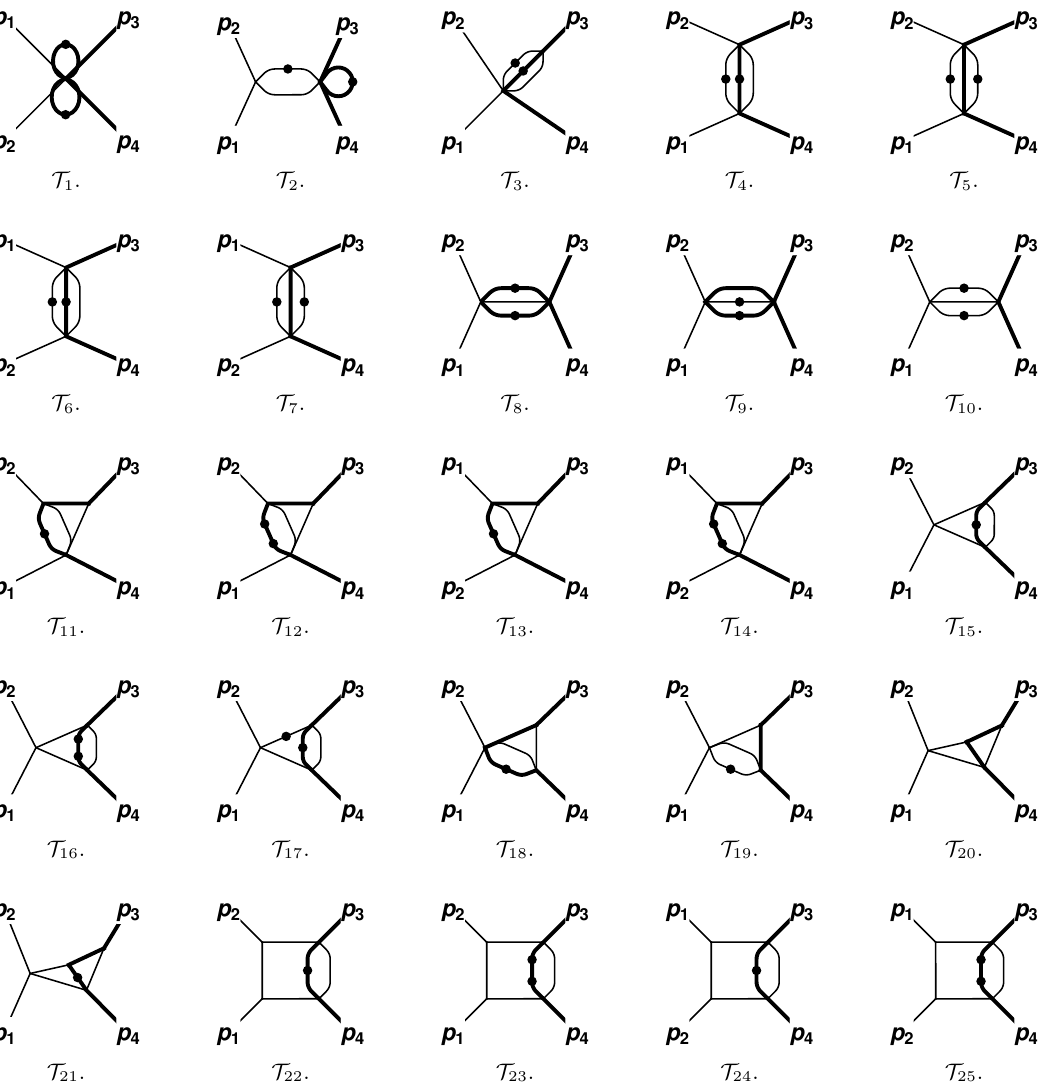
Figure 2. The (cid:12)rst 25 MIs T 1 ;:::; 25 for the two-loop non-planar topology N 2 of (cid:12)gure 1. Massless propagators are represented by think lines and massive propagators by thick ones. Each dot in- dicates an additional power of the corresponding propagator. Numerator insertions are indicated explicitly on top of each